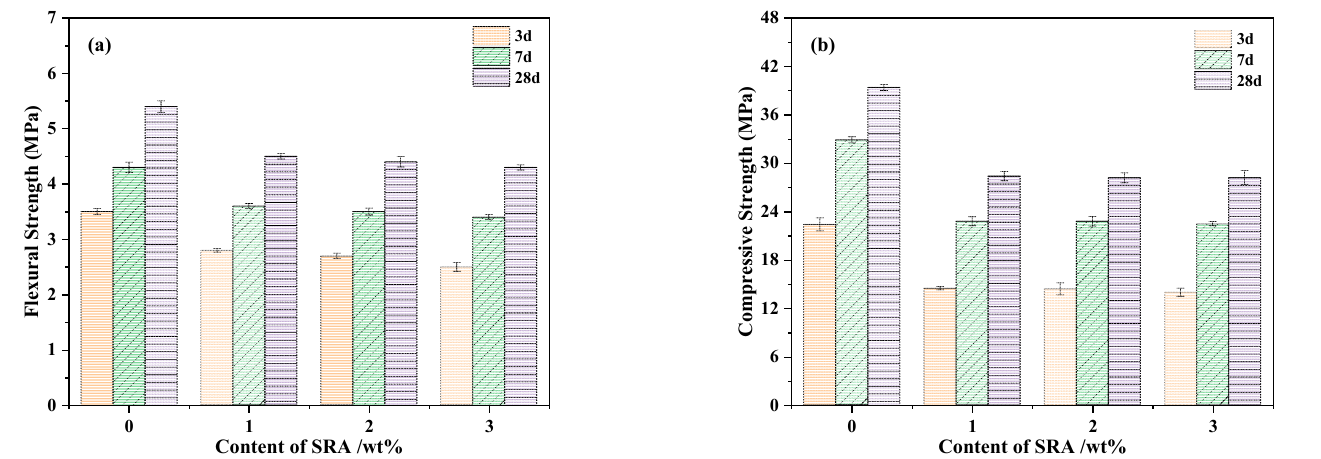
Figure 8. ( a ) Flexural strength and ( b ) compressive strength of M-S-H mortar with SRA.